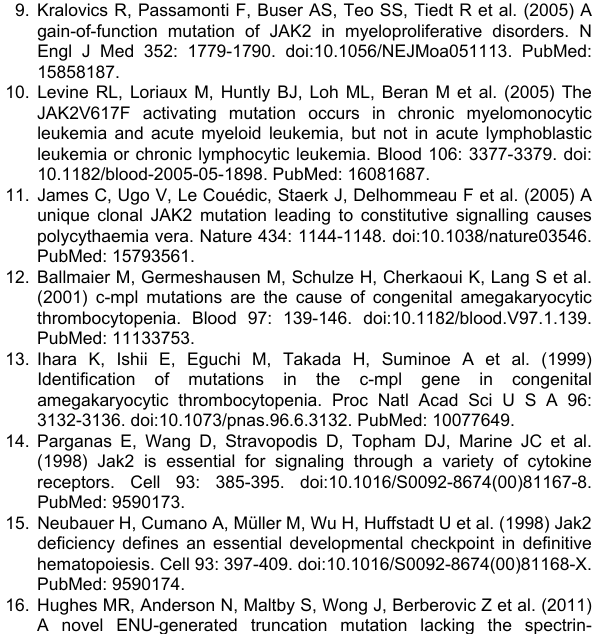
Figure S3. 5FU hematopoietic challenge of Jak2 K915X/- and Jak2 +/- results in similar recovery. The recovery curves for